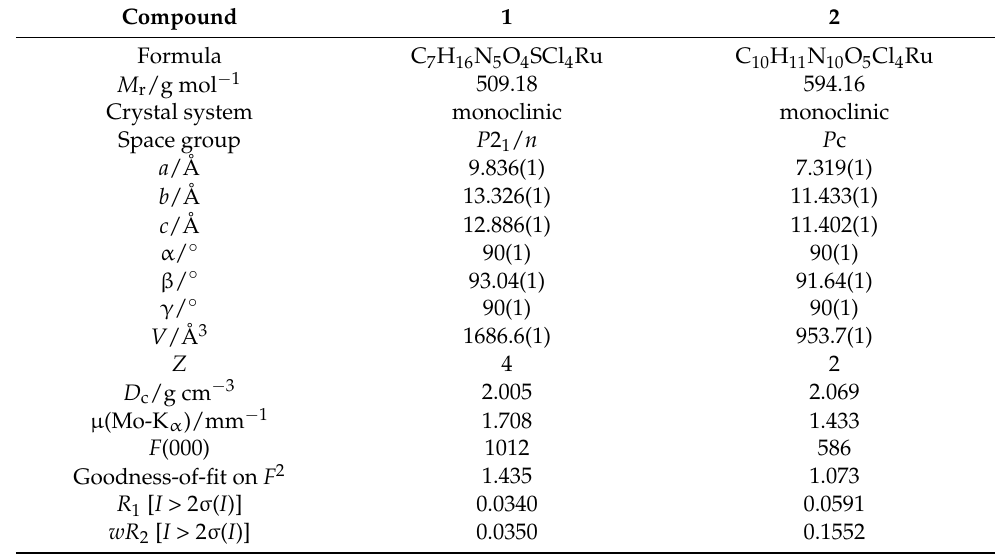
Figure 1. View of the [RuCl 4 (Hgua)(dmso)] and [RuCl 4 (Hgua)(gua)] complexes showing the atom numbering of the Ru(III) metal ions together with those of their chromophores in 1 ( a ) and 2 ( b ). Water molecules and H atoms have been omitted for clarity. Thermal ellipsoids are shown at the 50% of probability.